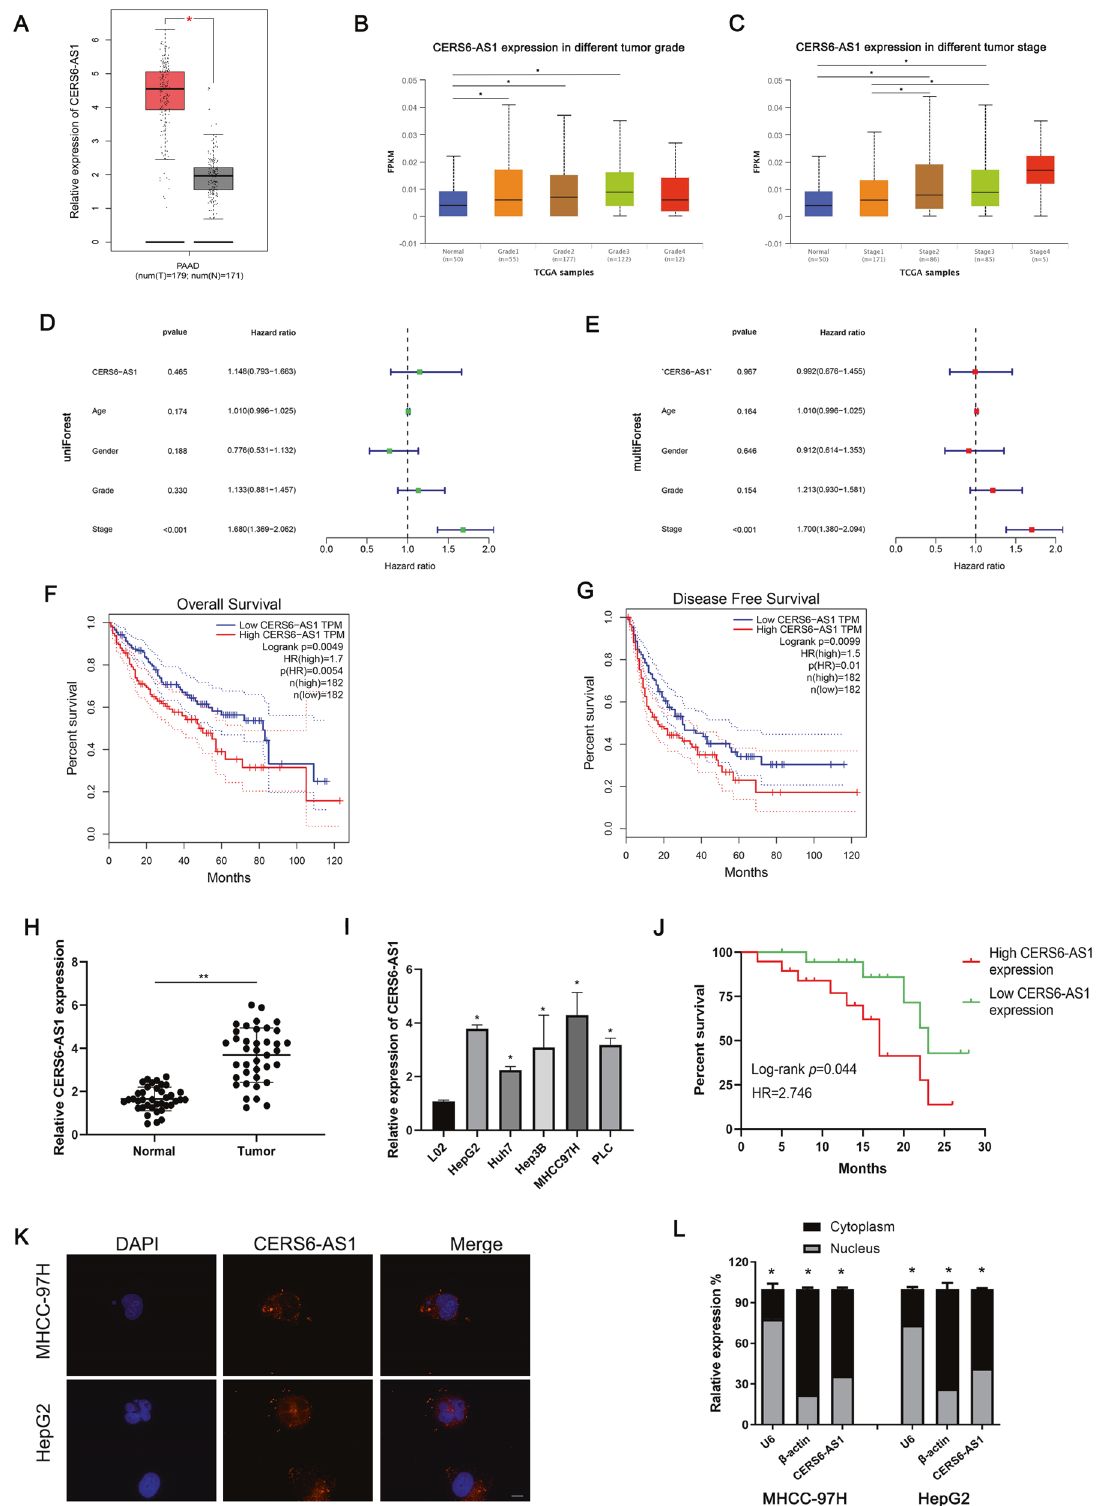
tumor hypoxic microenvironment can induce increased expres- sion of c-Myc in tumor cells, facilitating aerobic glycolysis by enhancing c-Myc-mediated transcriptional regulation of key glycolysis genes, such as PKM2, GLUT1 and HK2 genes [13].